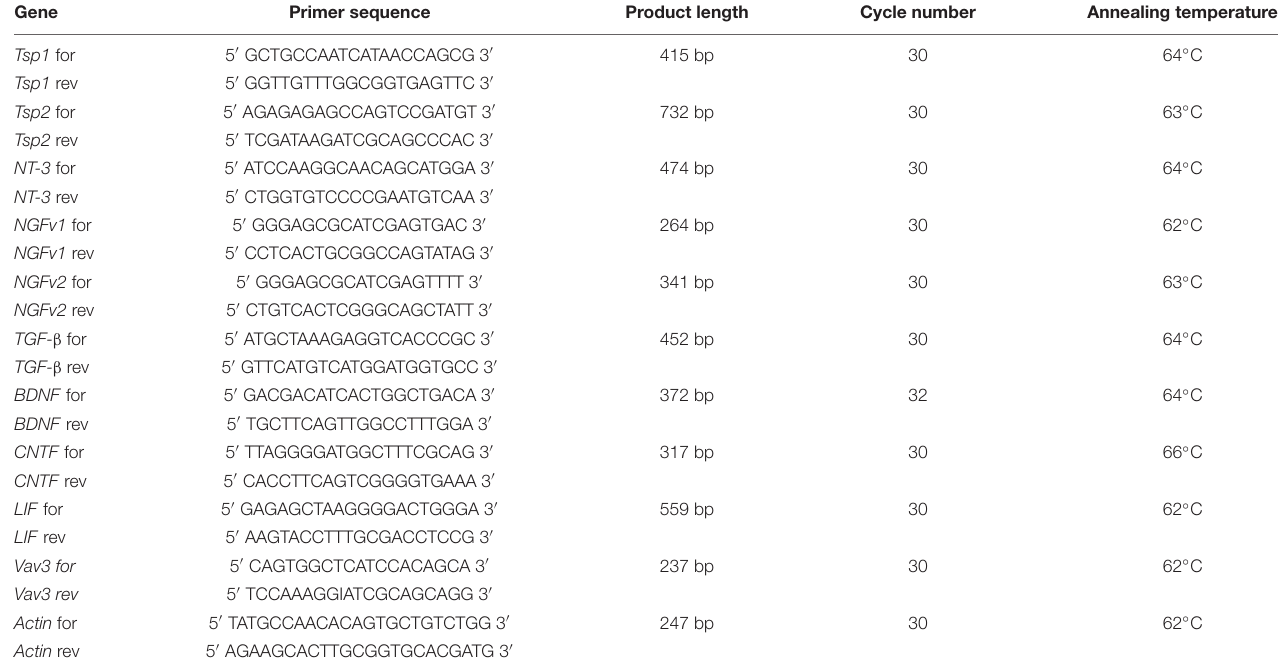
TABLE 1 | Primer sequences and PCR